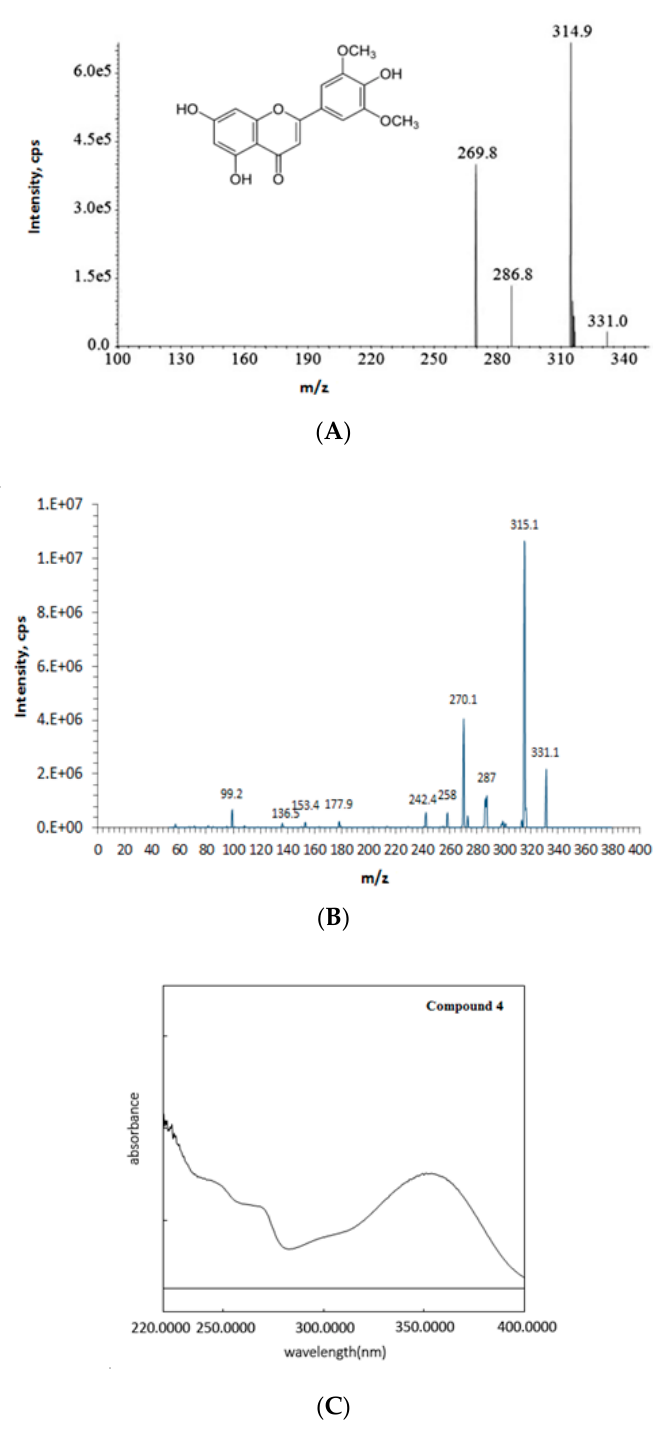
Figure 6. Relevant tandem mass (MS/MS) spectra. ( A ) Tricin (from literature [11]); ( B ) isolated and purified compound ( 4 ). ( C ) Compound ( 4 ) has absorption peaks ( λ max ) at 351 nm. A control of 100% methanol was used and auto-zeroed automatically by the software.